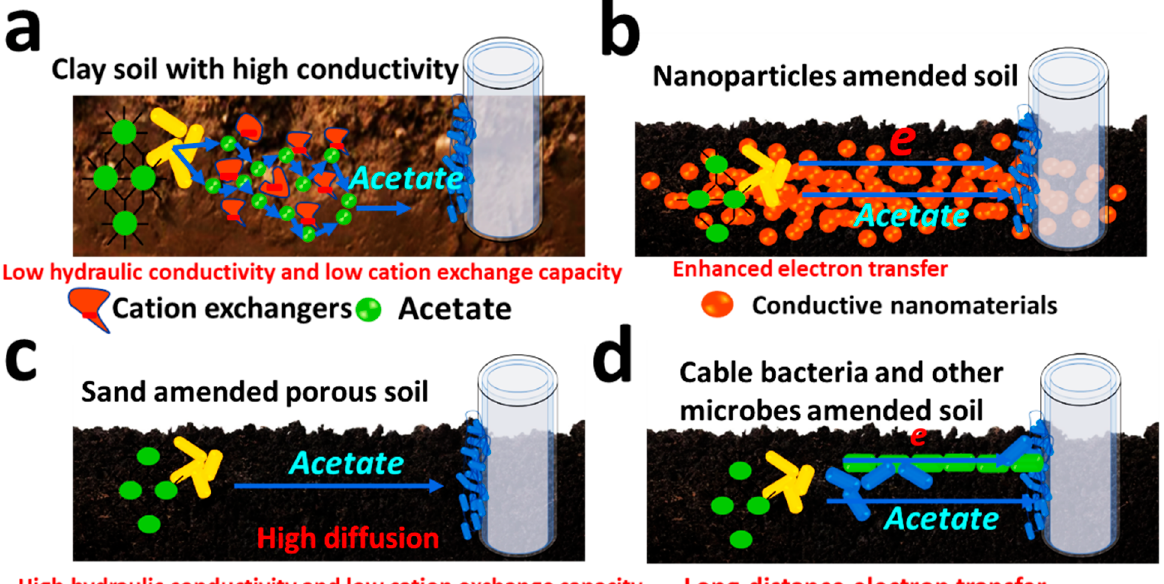
Figure 2. Physiochemical features of soils and their impact on microbial interaction for electron exchange: ( a ) clay soil with high cation exchange capacity; ( b ) nanoparticle-amended soil ( c ); sand- amended soil with high hydrohalic conductivity; ( d ) application of cable bacteria for long-distance electron transfer.